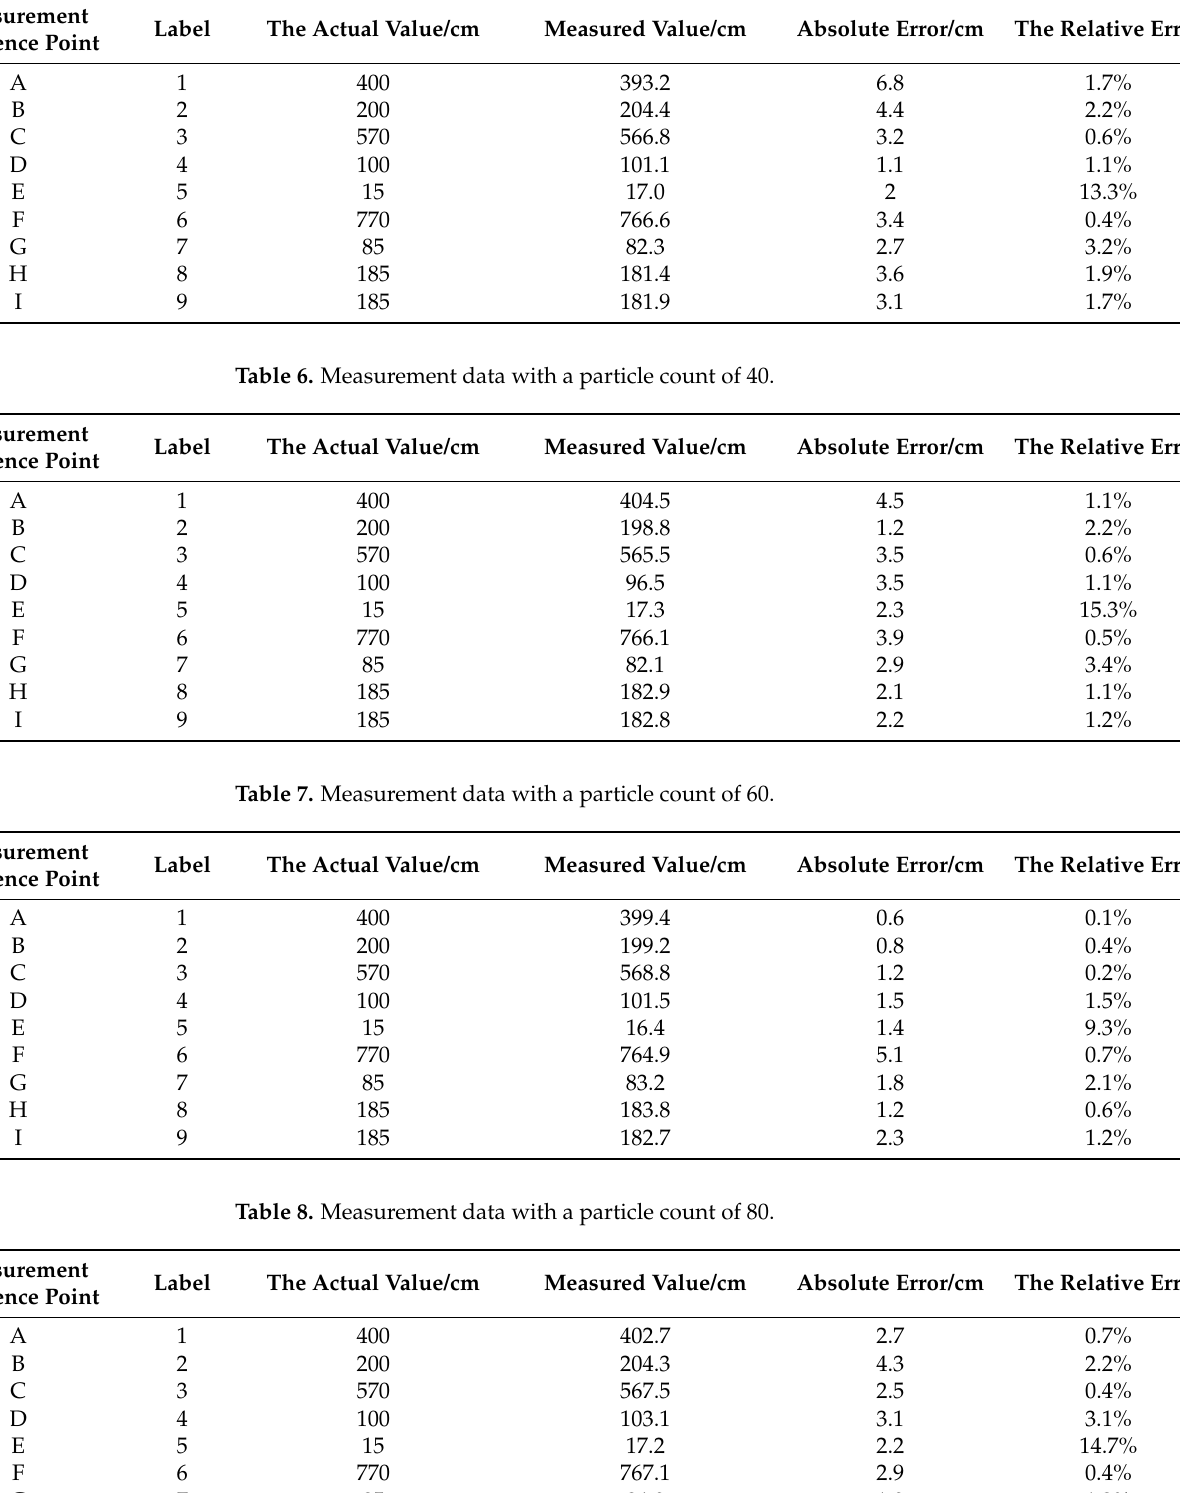
Table 5. Measurement data with a particle count of 20.